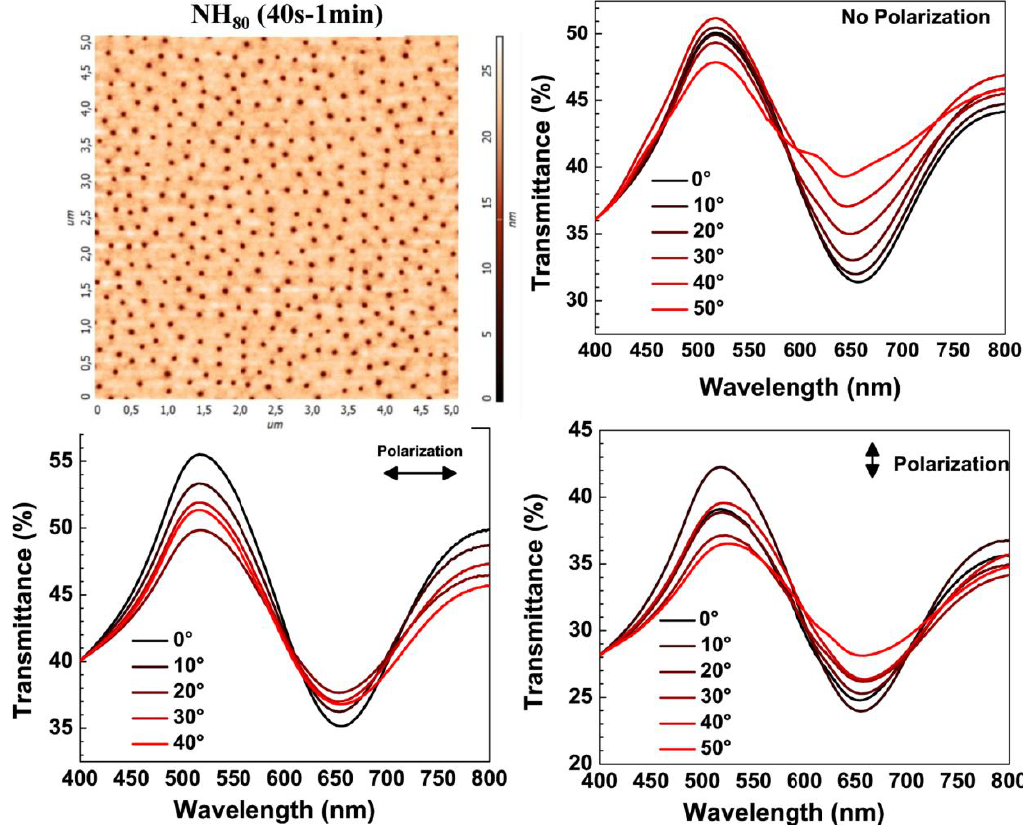
Figure 7. AFM topography of NH 80 (40 s–1 min) ( topmost-left panel ). Transmittance spectra versus incidence angle of unpolarized exciting light ( top-most right panel ). Transmission spectra versus incidence angle for two orthogonal linear polarizations of the exciting light ( bottom row panels ).